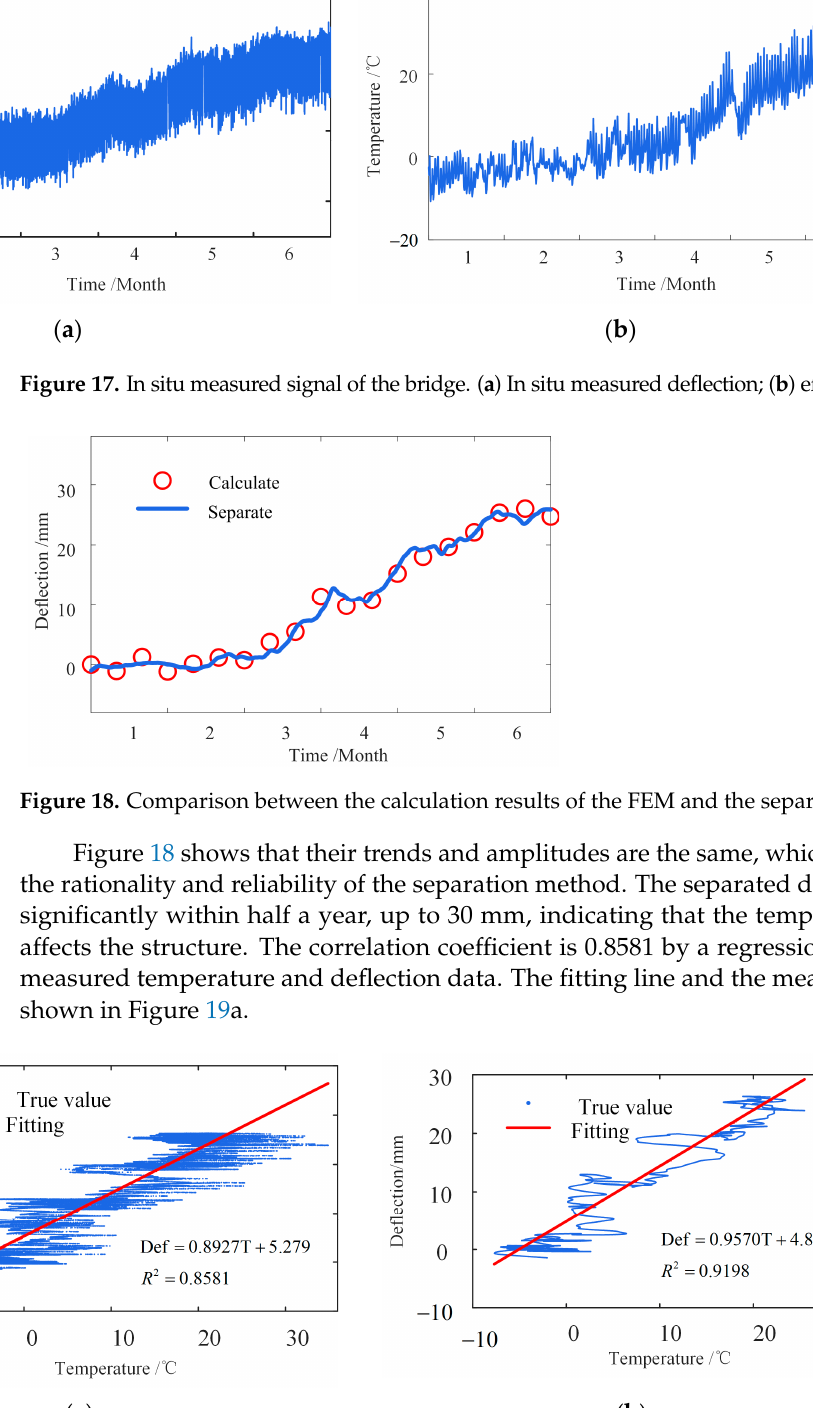
Figure 19. Correlation between separated deflection and temperature before and after filtering. ( a ) Temperature before filtering; ( b ) temperature after